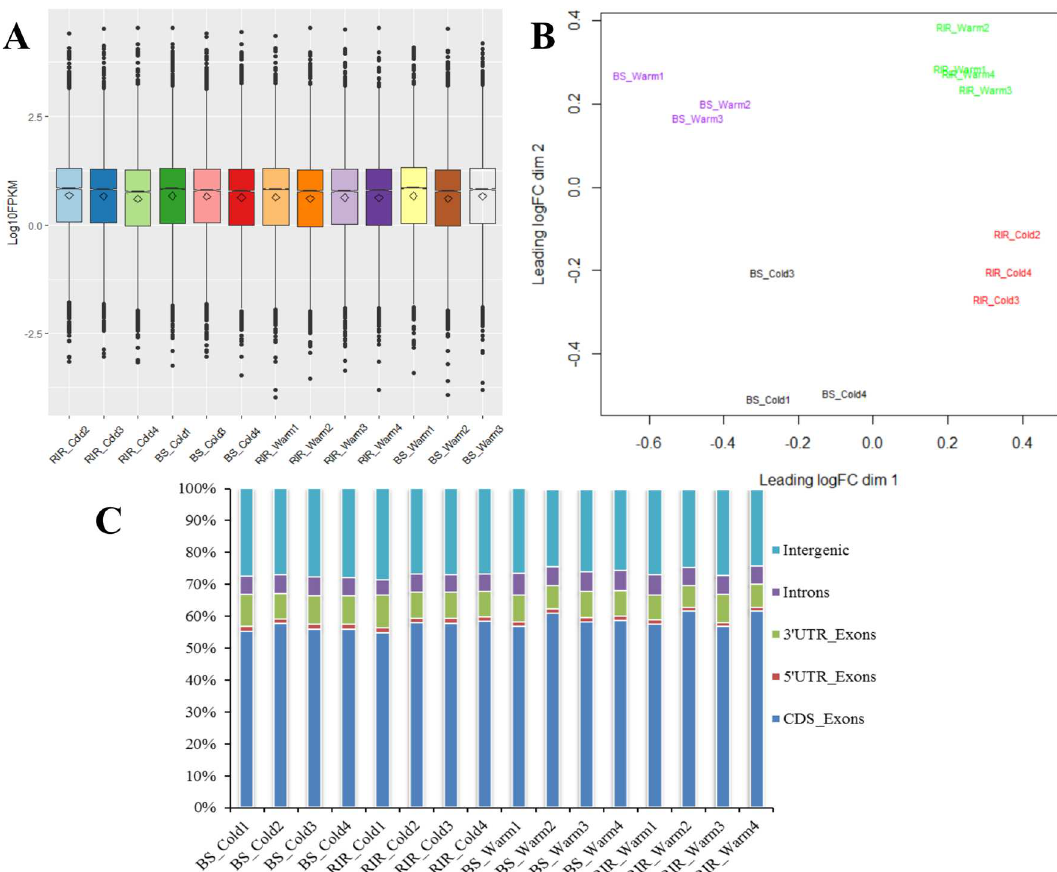
Fig 2. Gene expression patterns and mapped read distributions. (A) Distributions of gene expression levels. Each box plot contains hinges at the 25 th and 75 th percentile, a line at the median, and a rhombus at the mean. (B) MDS plots showing the divergence between groups. (C) Distributions of the mapped reads.